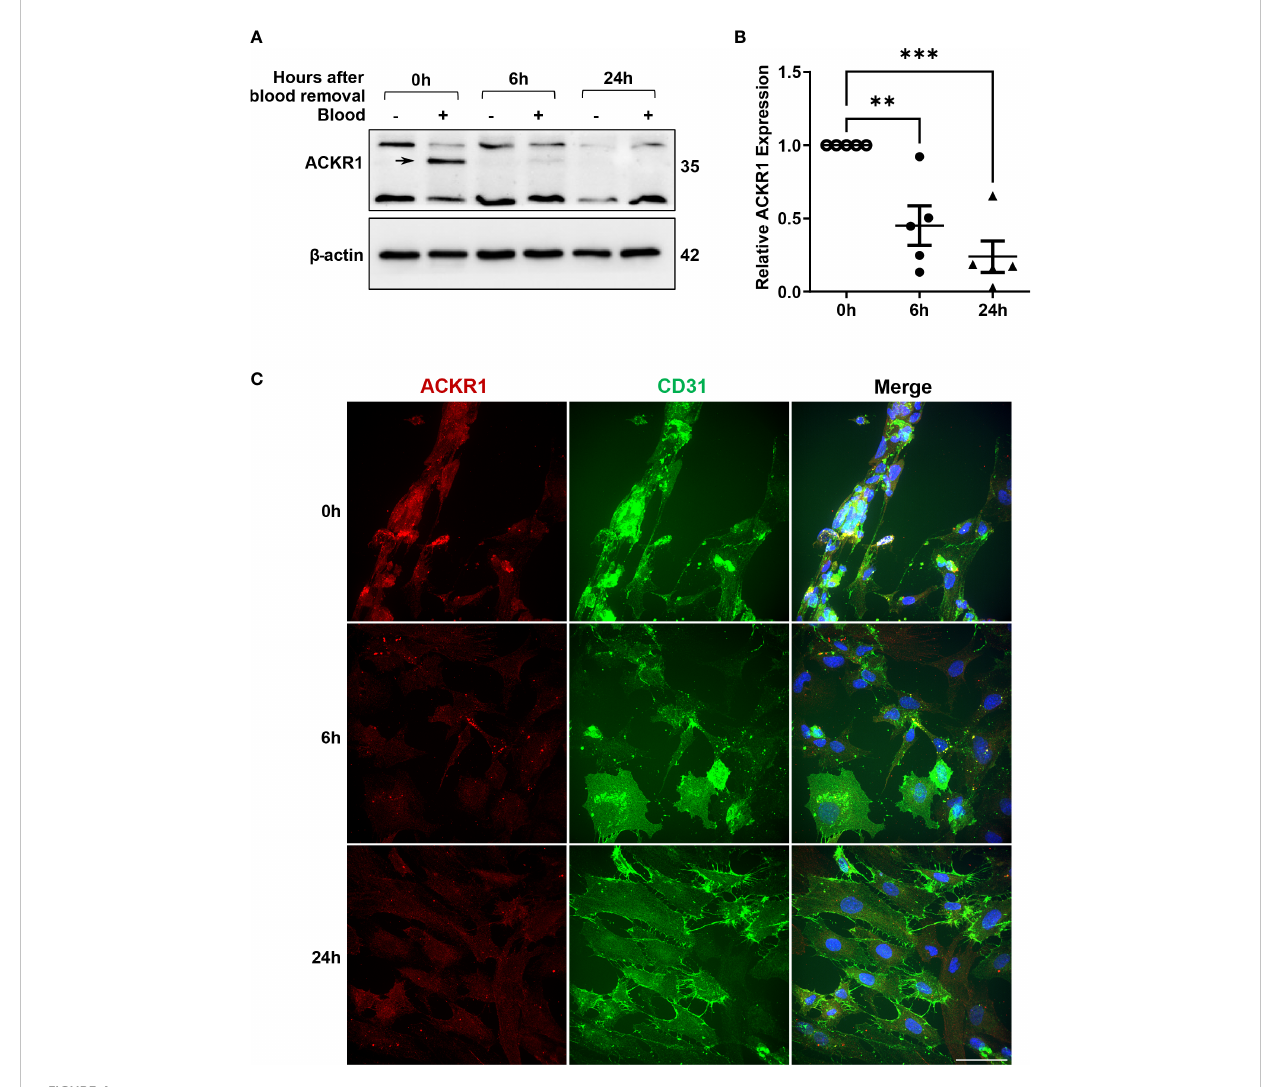
FIGURE 4 Rapid loss of ACKR1 protein and mRNA upon removal of blood. (A) After incubation with blood for 24 hours, blood was removed and endothelial lysates were probed for ACKR1 by immunoblotting using the Ab58965 antibody. (B) qPCR for ACKR1 mRNA under the same conditions (**p<0.01; ***p<0.001). (C) Immunostaining for ACKR1 and CD31 under the same